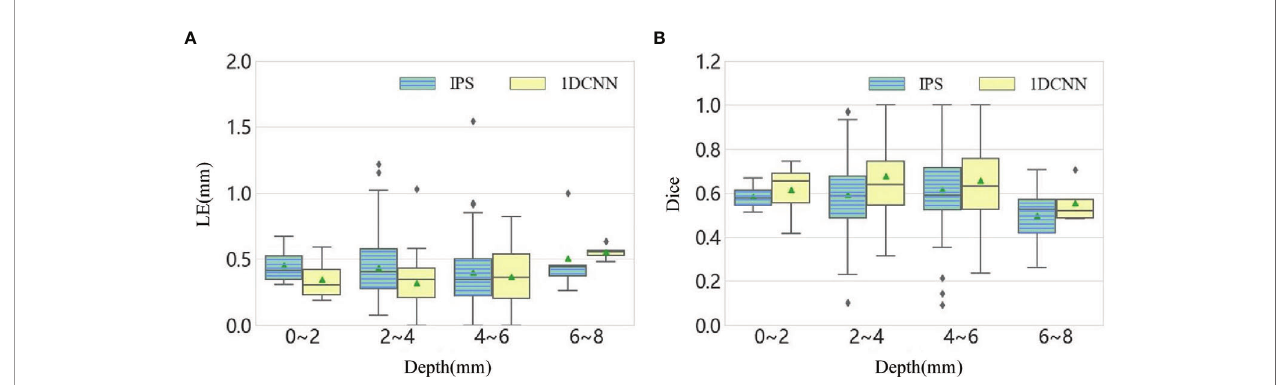
FIGURE 2 | (A) The boxplot chart of the LE for all single-source samples, where the samples are divided into four groups according to the depth. (B) The corresponding boxplot chart of the